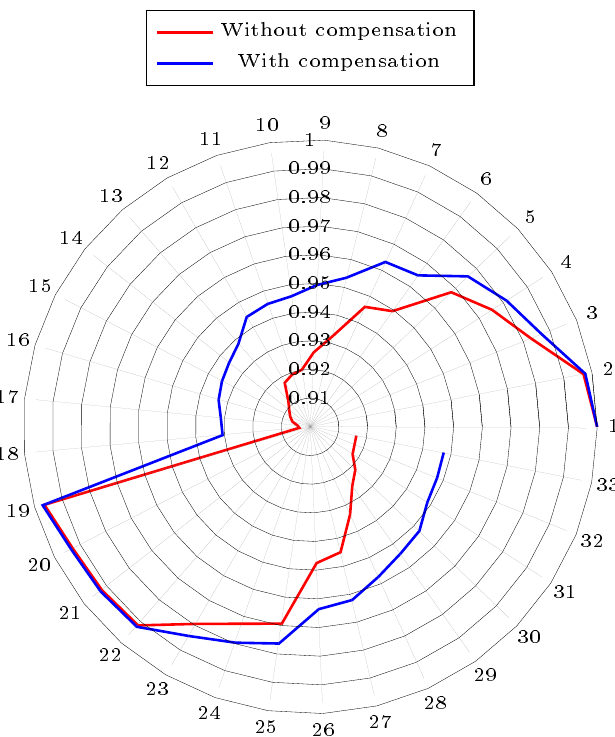
Figure 5. The impact of compensated devices on the voltage profile for the 33-node test feeder.